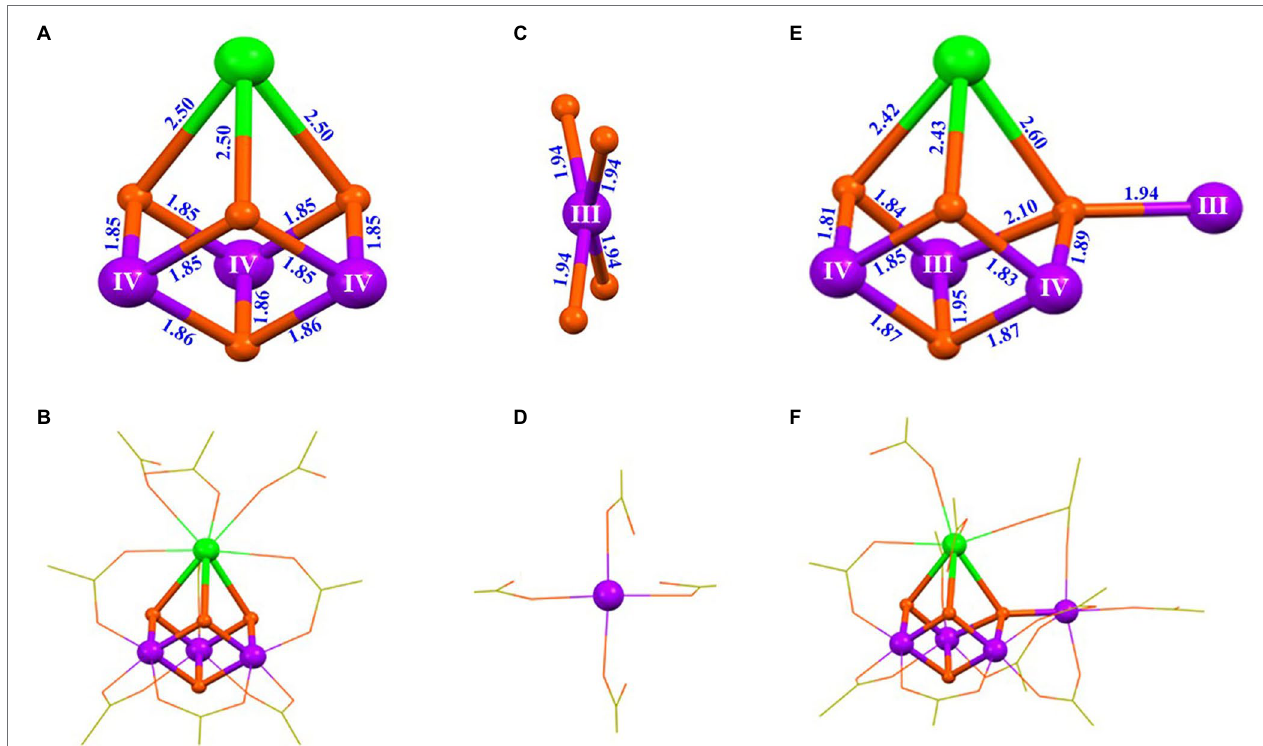
FIGURE 7 | Structures of three intermediates for the synthesis of the artificial Mn 4 CaO 4 -cluster (Chen et al., 2022). (A) Core of [Mn 3 CaO 4 (tBuCO 2 ) 6 (tBuCO 2 H) 3 ] ( 5 ); (B) structure of 5 ; (C) Mn center in [ n Bu 4 NMn( t BuCO 2 ) 4 ] ( 6 ); (D) structure of the [Mn( t BuCO 2 ) 4 ] − anion in 6 ; (E) core structure of [Mn 4 CaO 4 ( t BuCO 2 ) 8 ( t BuCO 2 H) 3 ] ( 7 ); (F) structure of 7 . All other illustrations are the same as those in Figure 5